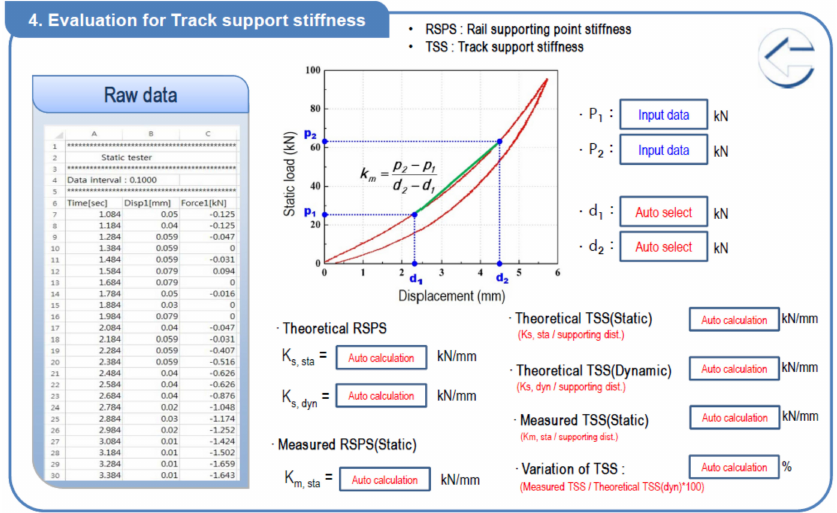
Figure 10. Example of the test result for the load–displacement curve.